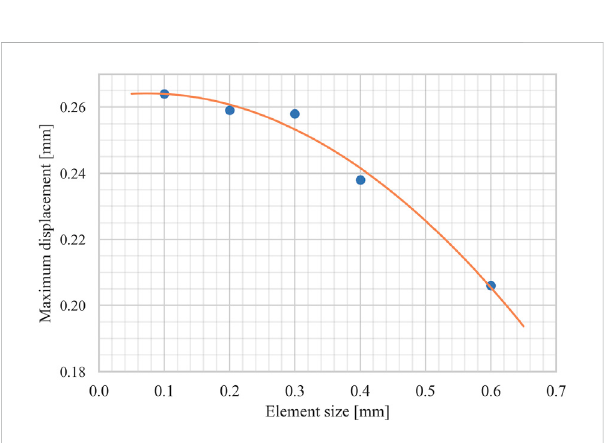
FIGURE 5 The mesh convergence analysis results. The maximum displacement of the plate was measured for different element sizes, ranging from 0.6 mm to 0.1 mm.